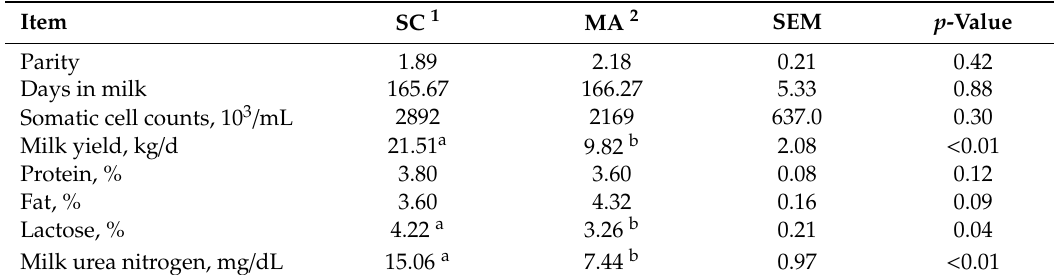
Table 1. Milk performance characteristics of dairy cows from the subclinical mastitis (SC) and true mastitis (MA) group.